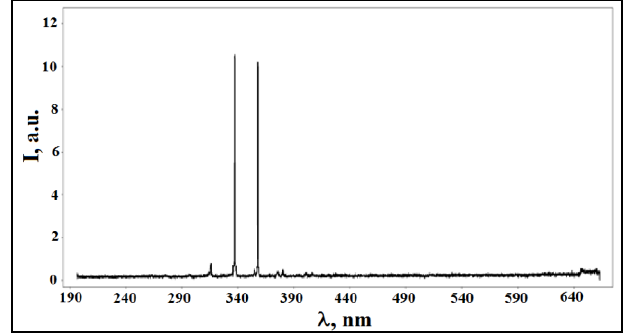
Figure 5. The emission spectrum of the discharge above the surface of distilled water at an air pressure in the discharge chamber equal to 101 kPa. Table 1. The results of the interpretation of the emission spectrum of the discharge formed above the surface